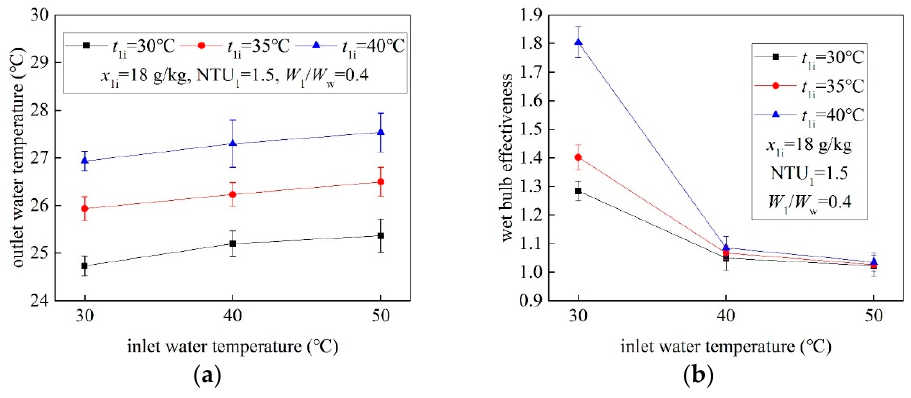
Figure 9. Impact of the inlet water temperature on the performance of the MCT: ( a ) t wi vs. t wo ; ( b ) t wi vs. ε WB .